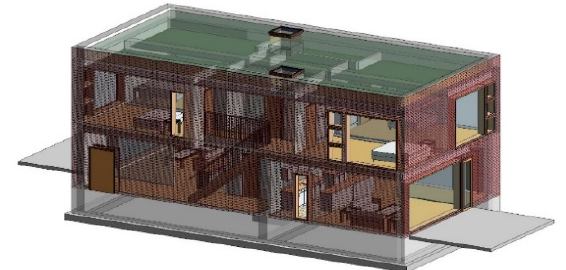
Figure 9. Building model used in the example (buildingSMART International).